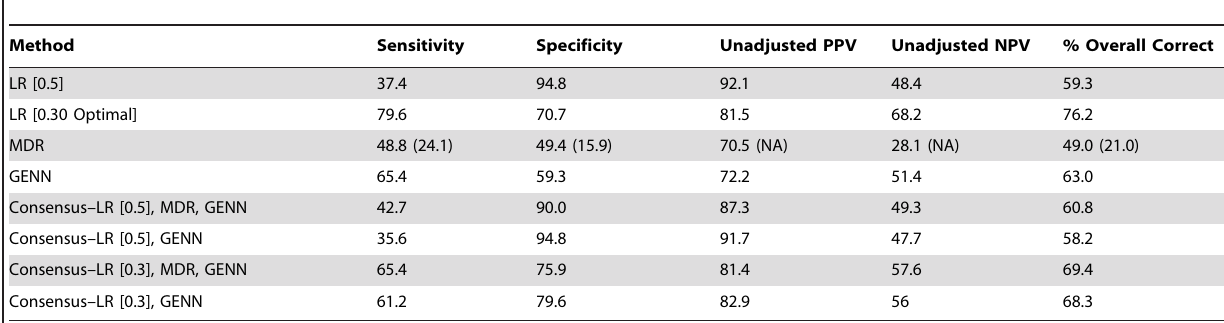
Table 8. Classification rates using the ARMA dataset for training and VM training combined with VM testing as the testing dataset.